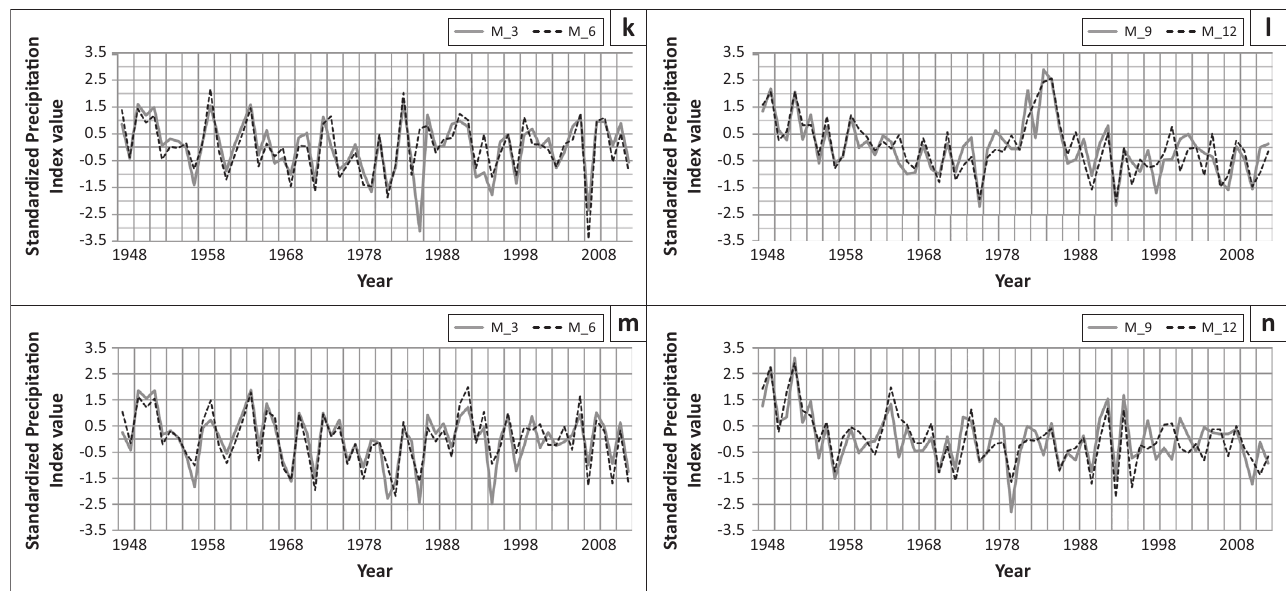
FIGURE 4 (Continues…): Drought in (a) Dhaka, (c) Mymensingh, (e) Faridpur, (g) Madaripur, (i) Tangail, (k) Chandpur and (m) Comilla based on 3-month SPI (M_3) and 6-month SPI (M_6). Drought in (b) Dhaka, (d) Mymensingh, (f) Faridpur, (h) Madaripur, (j) Tangail, (l) Chandpur and (n) Comilla based on 9-month SPI (M_9) and 12-month (annual) SPI